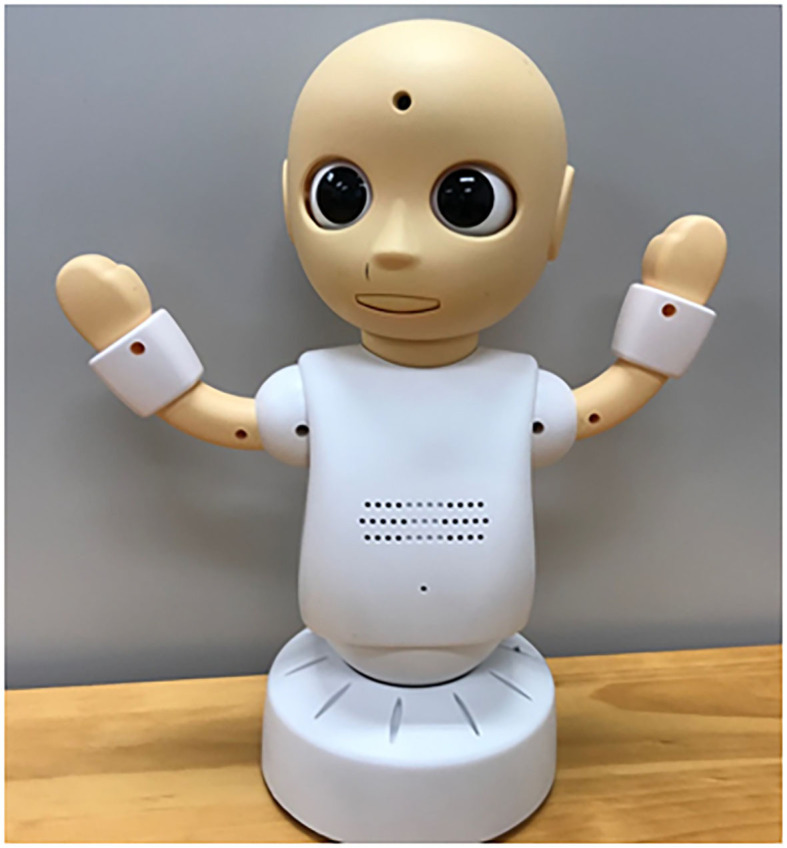
The CommU robot.